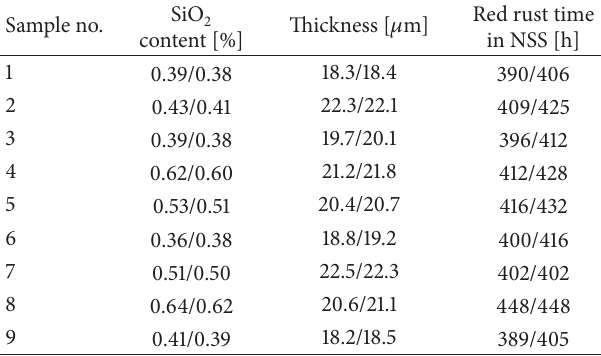
Table 4: SiO content (mass %), thickness, and erosion resistance of 2 composite coatings in different areas of iron plate for V = 2000 r/min and ℎ = 10 mm.